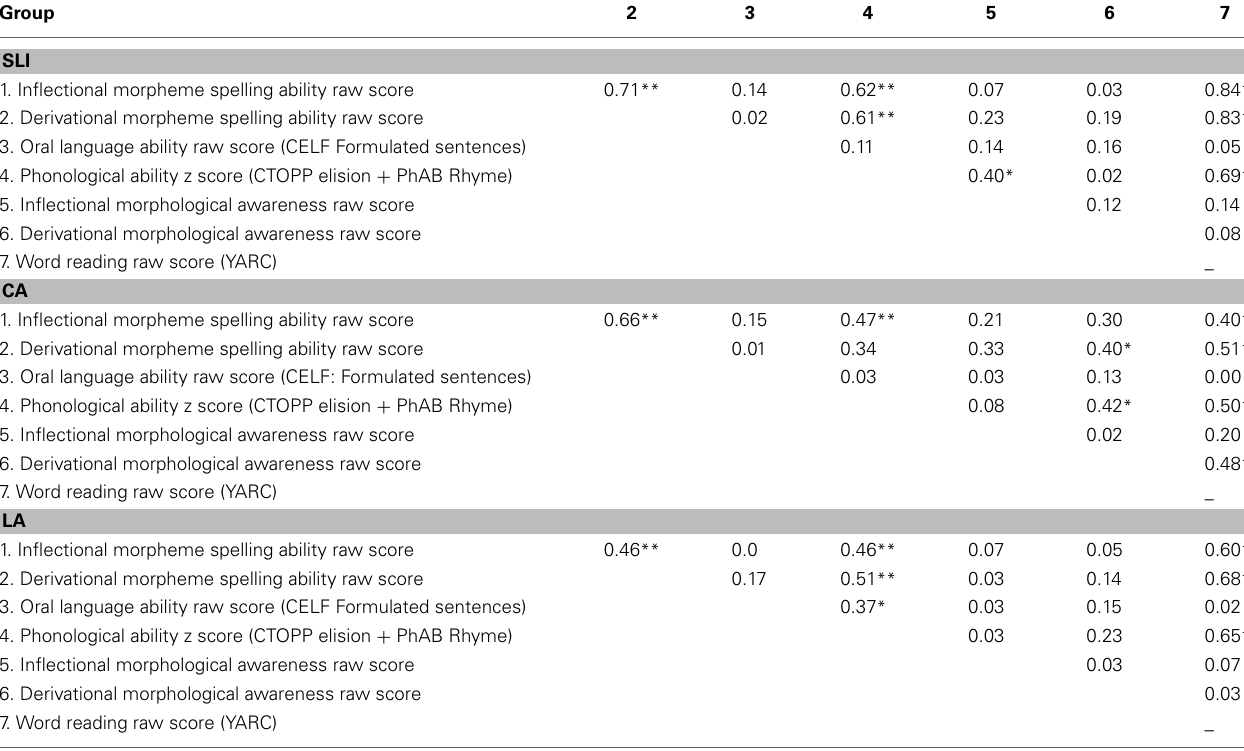
Table 4 | Correlations between various measures according to group (SLI, CA, LA) controlling for non-verbal ability. Group 2 3